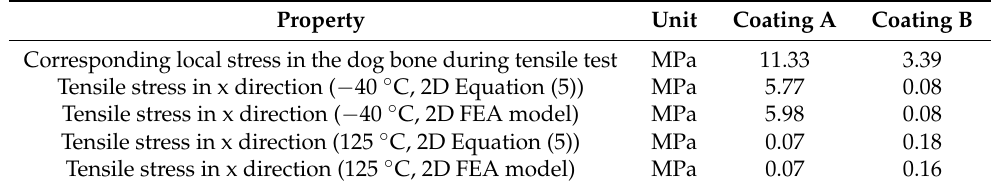
Table 5. Conformal coating tensile performance compared with calculated and FEA modeling of lateral tensile